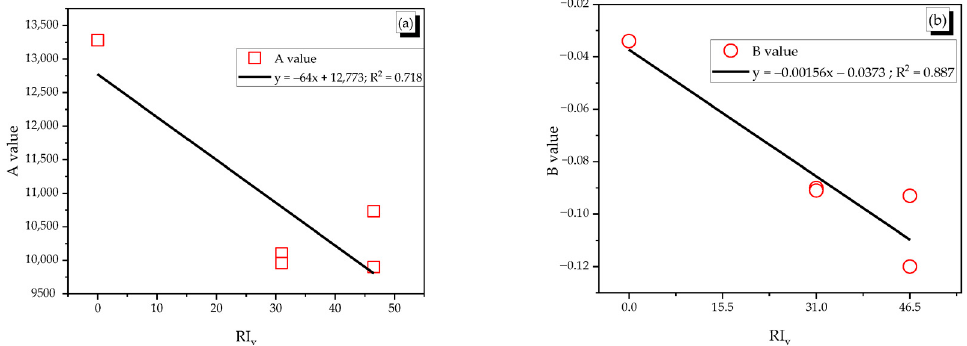
Figure 16. Relation between A and B coefficients and reinforcing index RI v, ( a ) Relation between A coefficient and reinforcing index, ( b ) Relation between B coefficient and reinforcing index.